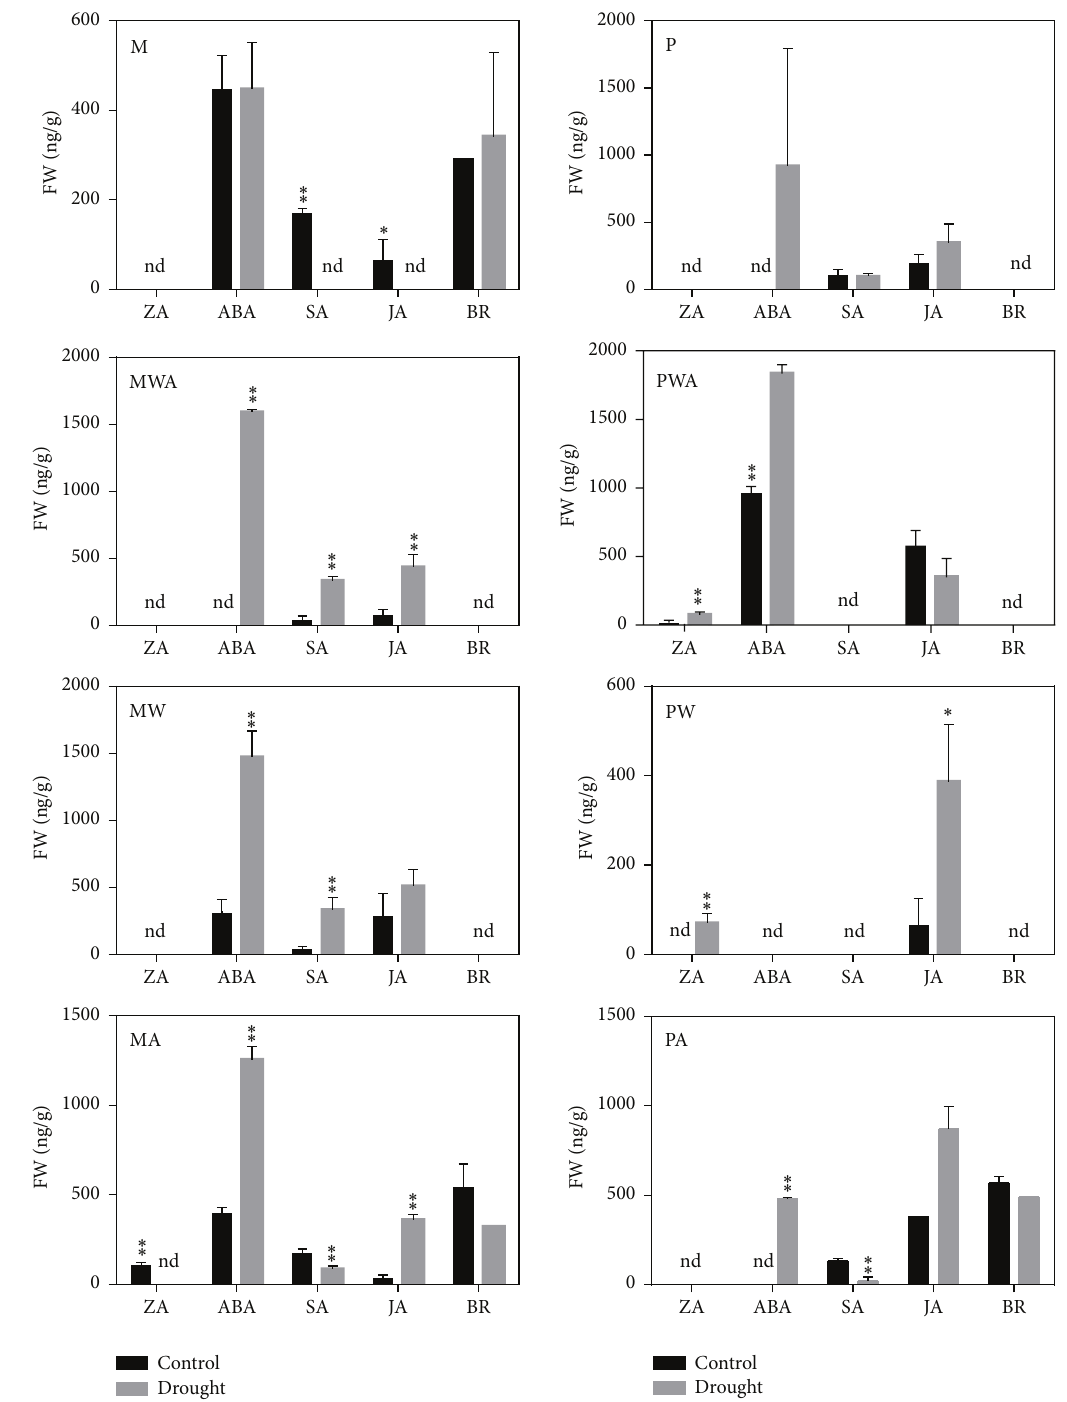
Figure 4: Effect of solvents on plant hormone extraction. Concentration of endogenous plant hormones (ZA, ABA, SA, JA, and BR) which were extracted by eight different solvents [P-100% isopropanol, M-100% methanol, PW (75 :25, isopropanol: water), MW (75 :25, methanol : water), PWA (75 :24 :1, isopropanol :water :acetic acid), MWA (75 : 24: 1, methanol : water :acetic acid), PA (99 :1, isopropanol :acetic acid), and MA (99 :1, methanol : acetic acid)] from control and drought-stressed A. thaliana rosette leaves. “FW” represents fresh weight of plant sample. Asterisks denote a significant hormonal difference between control and drought-stressed plants and “nd” refers to not detected ( 𝑛 = 2/3 , 𝑡 -test, ∗ 𝑃 < 0.1 , ∗∗ 𝑃 < 0.05